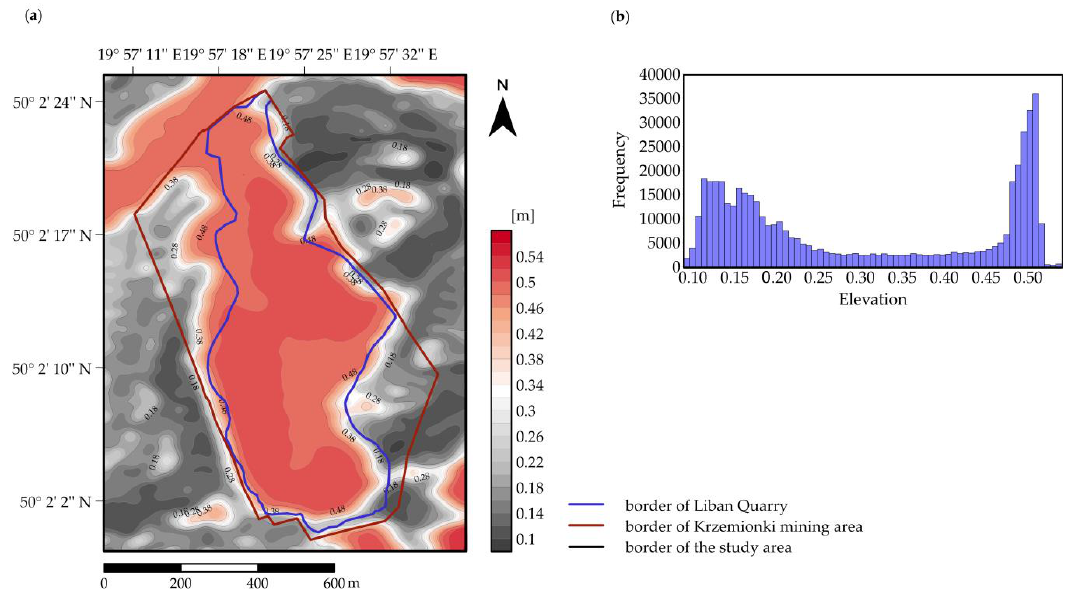
Figure 11. Standard kriging deviation (SD OK ): ( a ) map; ( b ) histogram of raster image calculated on the basis of the SD OK map.